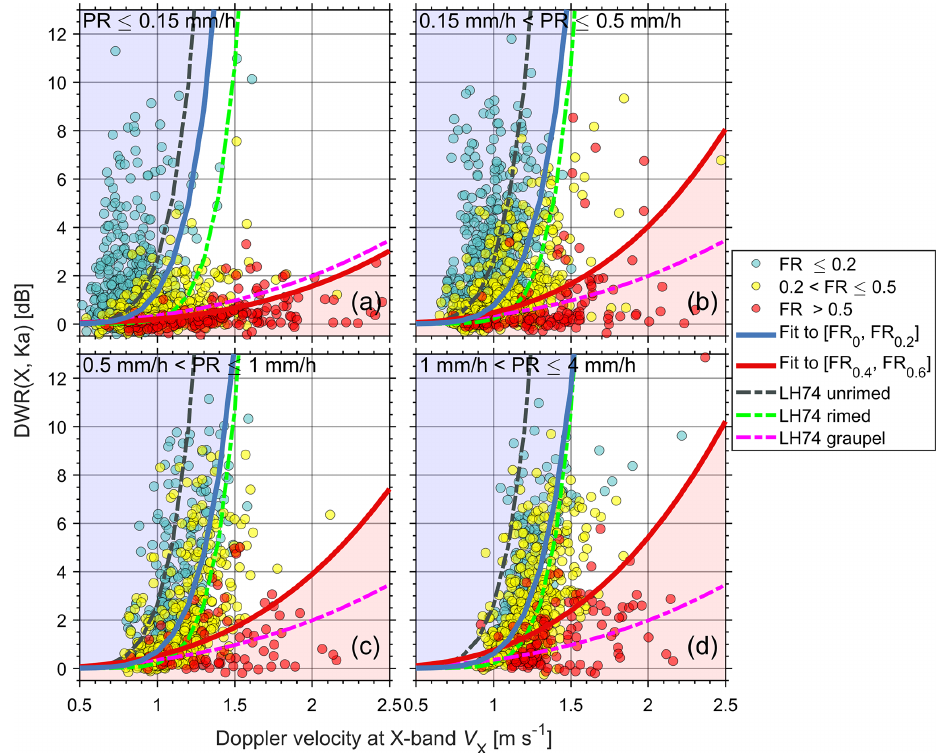
Figure 1. Scatter plot of DWR(X, Ka) versus V X (1000hPa and 0 ◦ C) colored with FR. Mass–size and velocity–size relations from Locatelli and Hobbs (1974) are adopted for reference (dashed lines). Observed mass–size and velocity–size relations are derived using the approach developed by von Lerber et al. (2017), and the particle backscattering coefficient σ b ,λ is adopted from Leinonen and Moisseev (2015) and Leinonen and Szyrmer (2015). The solid blue and red curves separate unrimed (light blue shading), transitional (no shading) and rimed snow (light red shading) in our classification scheme. Table 1. Fitted parameters for DWR(X, Ka) = aV b . Aggregates of unrimed radiating assemblages, side planes, bullets, and columns X (LH74 unrimed), aggregates of densely rimed radiating assemblages of dendrites (LH74 rimed), and lump graupel (LH74 graupel) in Lo- catelli and Hobbs (1974) are shown for reference. The last column shows the root mean square error (RMSE) of fitting. The confidence interval is marked by “ \ ” when the parameter is manually